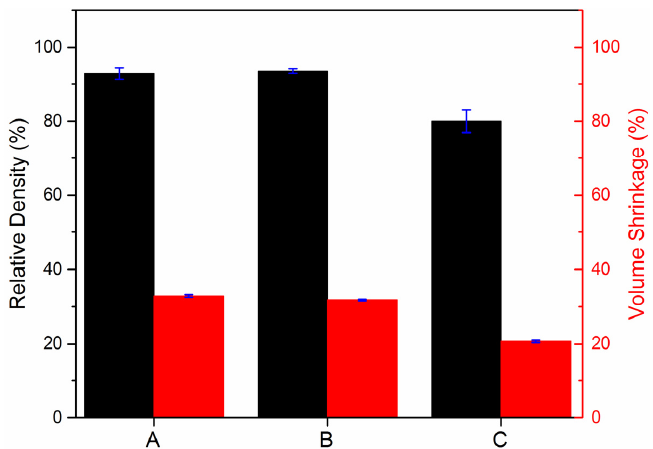
Figure 9. Relative densities and volume shrinkages after sintering for: ( A ) samples processed using commercial feedstock PolyMIM with the fine powder by plunger injection moulding; ( B ) samples processed using commercial feedstock PolyMIM with the fine powder by Arburg 320; ( C ) samples processed using current study feedstock with the coarse powder by plunger injection moulding. It can be seen that samples made using current study feedstock with the coarse Ti powder had a lower relative density than those made from commercial feedstock PolyMIM with the fine powder, and consequently higher porosity. This can be attributed to the size of the titanium powder used in this study compared to the commercial feedstock, where finer particles sinter at a much higher rate, resulting in greater growth of the necks and spheroidization of pores compared to coarser particles. However, the volume shrinkage after sintering for the samples made by commercial feedstock was found to be much greater than that of the samples made by the current study, where samples processed with the coarse powder shrank 20.7% in volume, while samples made of commercial